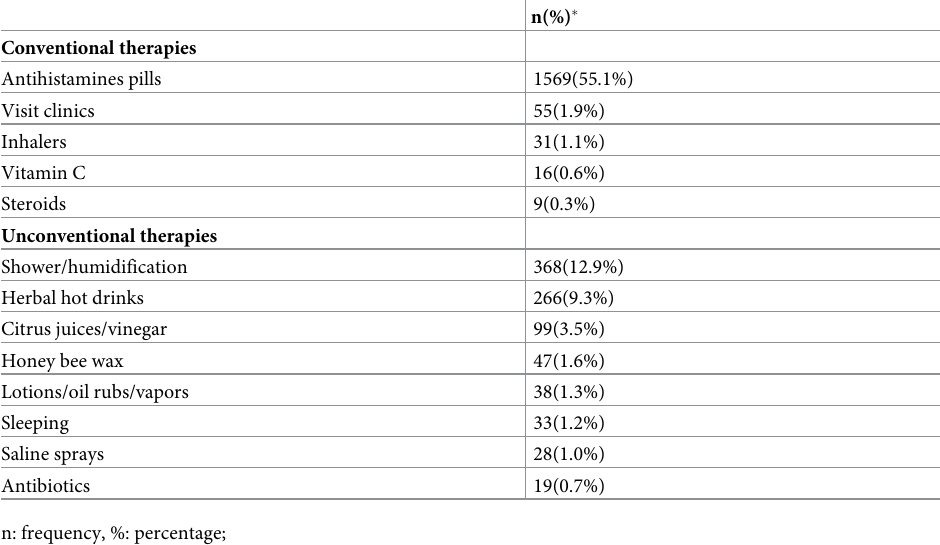
triggered by dust, compared to males (69.3%, P < 0.001). Older age group were also more likely to have AR triggered by pollen (19.8%), compared to younger participants (13.4%, P < 0.001). Younger AR participants were more likely to be affected by dust (77.7%), compared to their counter group (71.3%, P < 0.001). BMI and a family history of AR showed no statistically sig- nificant differences across the type of triggers. However, being a smoker was associated with AR triggers such as pollen (20.7%, P = 0.028) and furred animals (6.1%, P = 0.026), while non- smokers were more affected (75.3%, P = 0.003) by dust. Persistent AR was associated with mold (7.2%, P = 0.01). Moderate to severe AR was associated with pollen triggers (18.0%, Table 2. Conventional and unconventional AR coping